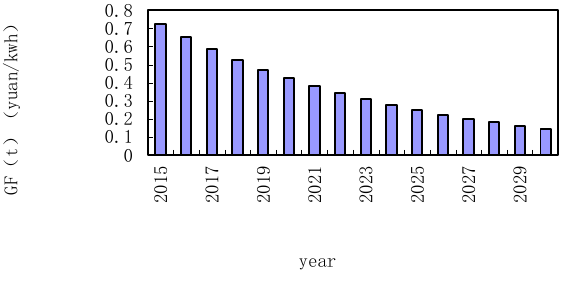
Figure 3. Photovoltaic (PV) power generation cost in 2016~2030.